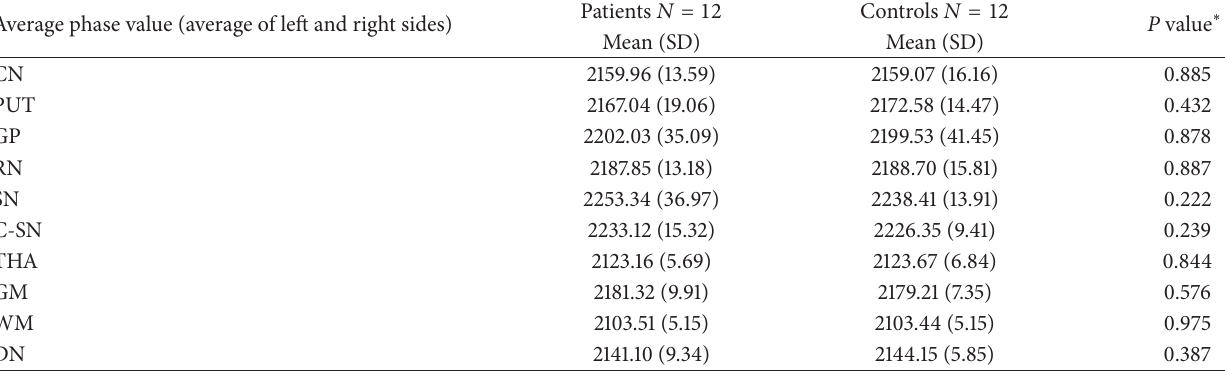
Table 2: Average phase value for each brain region after adjustment for age.